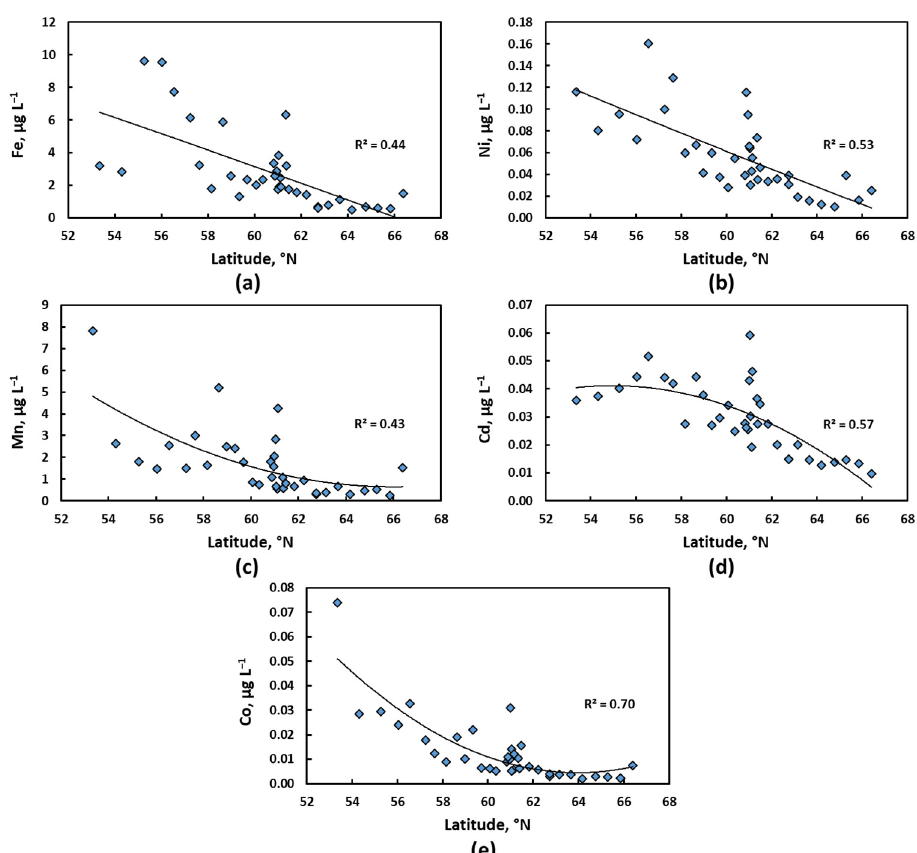
Figure 2. Examples of dissolved (<0.22 µm) metal concentrations in snow water as a function of latitude across the WSL. Fe ( a ); Ni ( b ); Mn ( c ); Cd ( d ); Co ( e ).